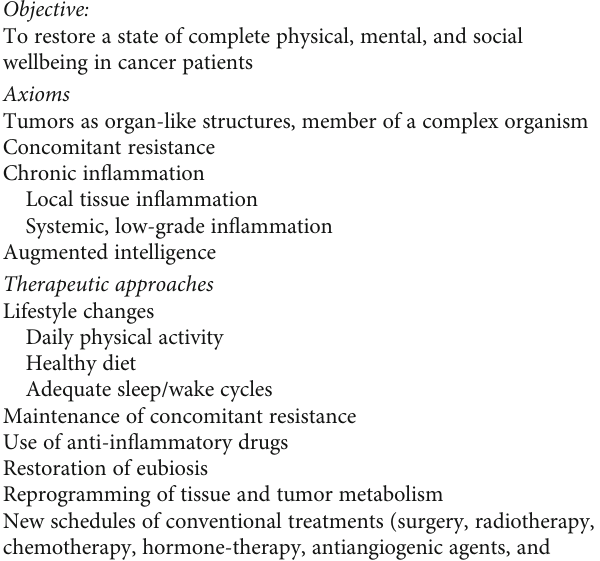
Table 1: The new cancer treatment paradigm: “ for systemic diseases, systemic methods of cure ”